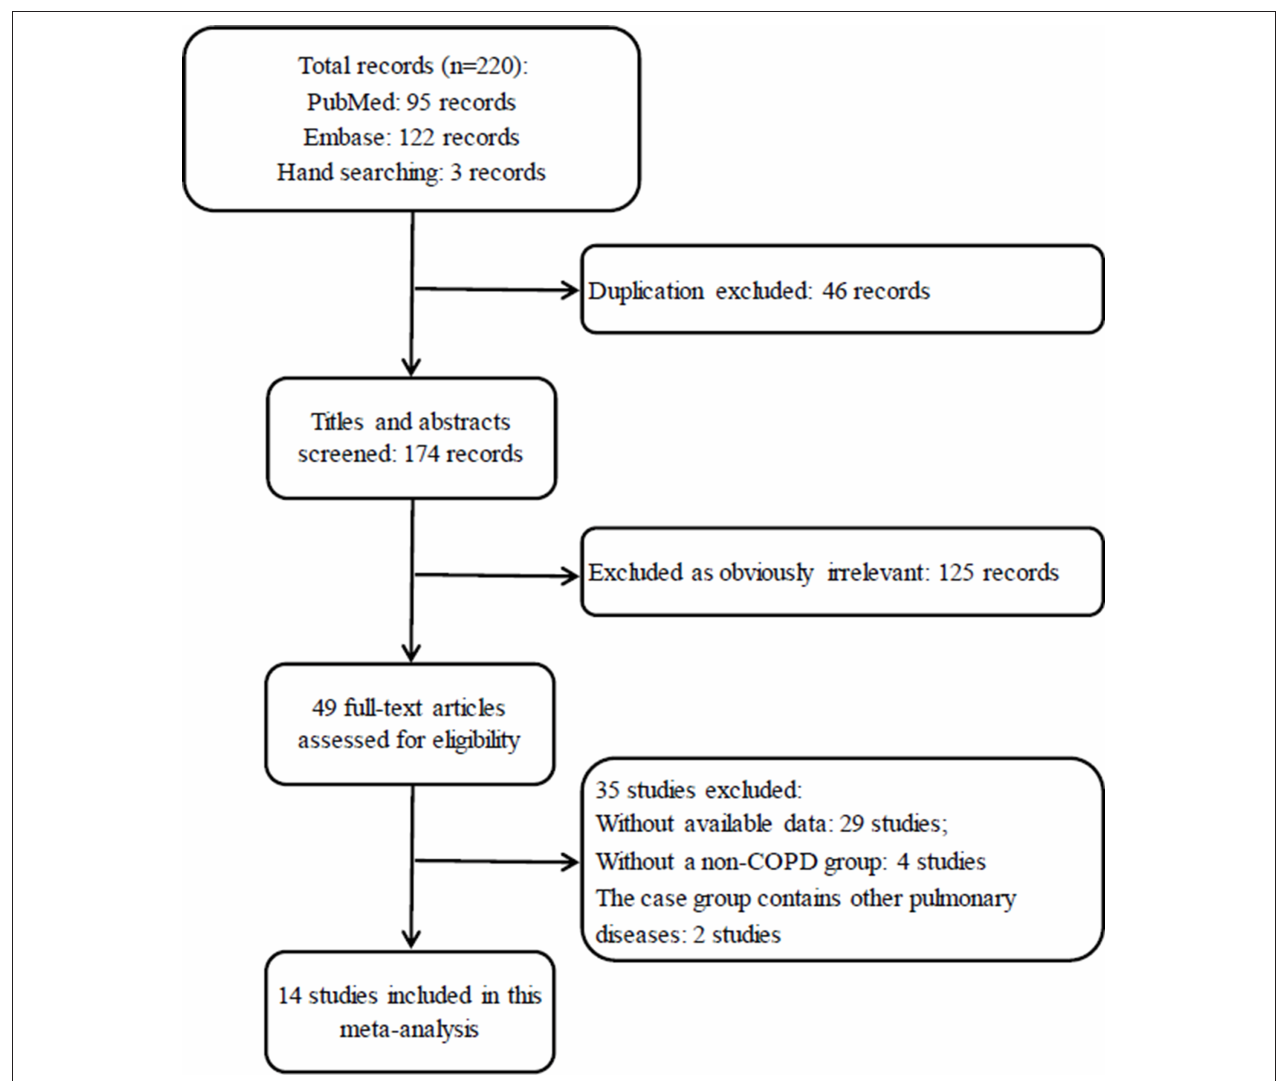
FIGURE 1 | Flow diagram for the selection of studies. COPD, chronic obstructive pulmonary disease.